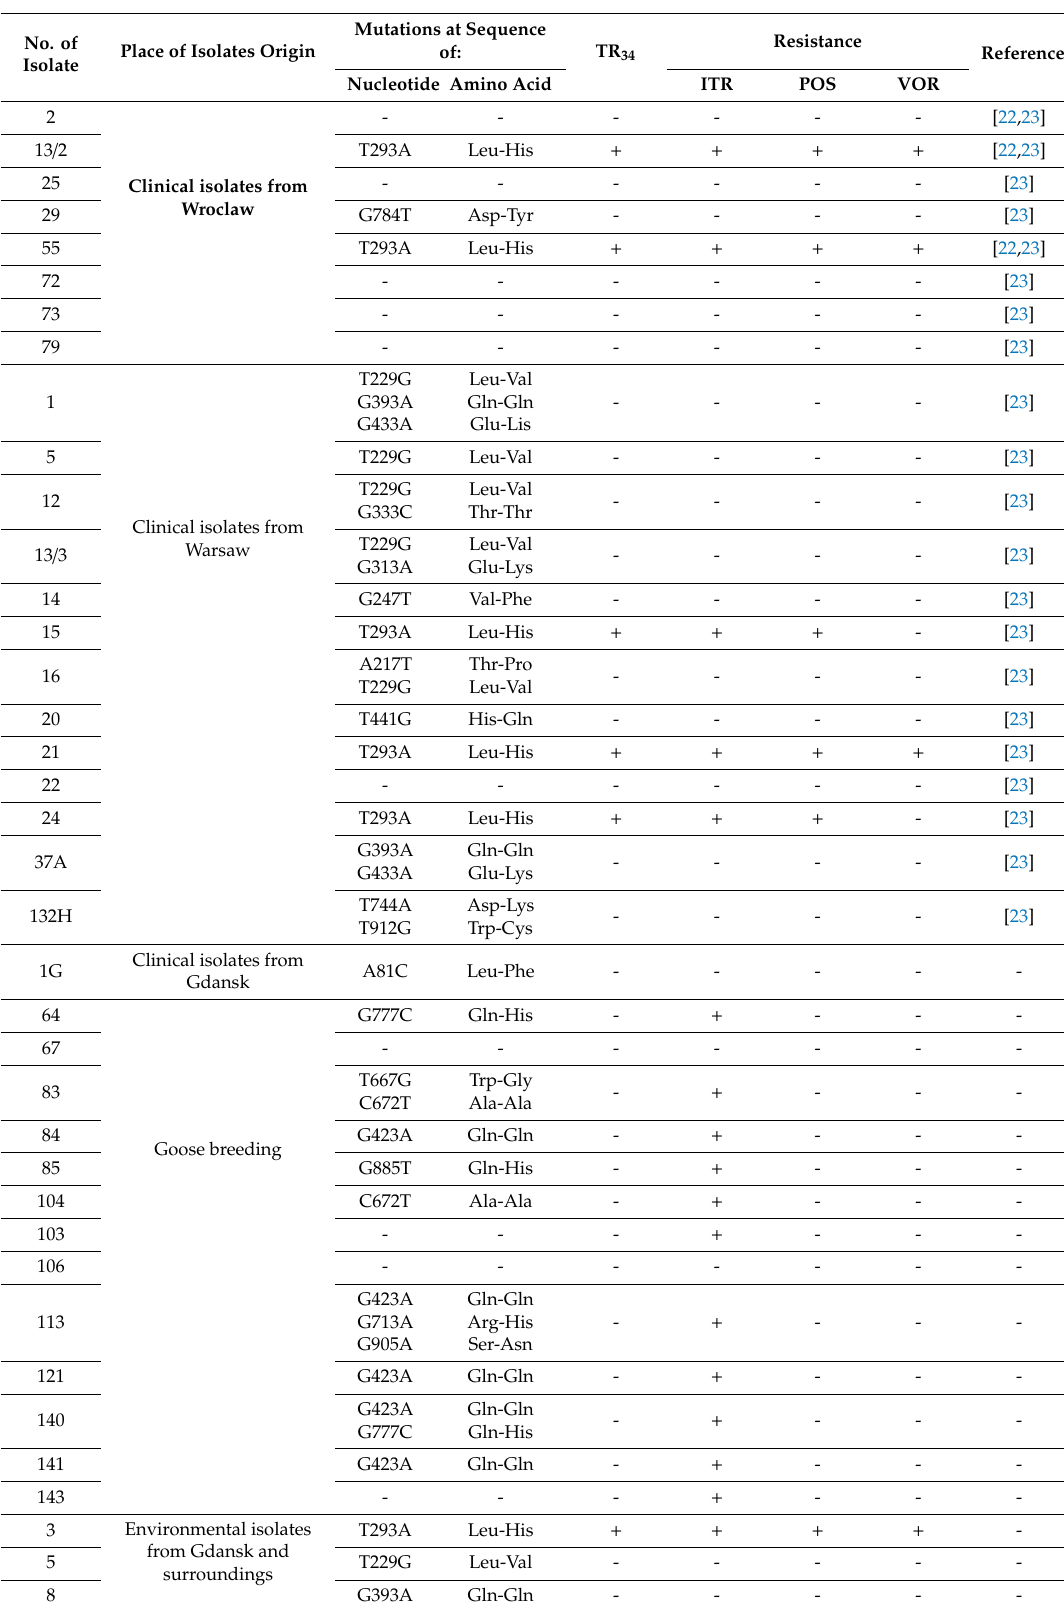
Table 1. Characterization of Aspergillus fumigatus isolates, cyp51 gene mutations and azole susceptibility